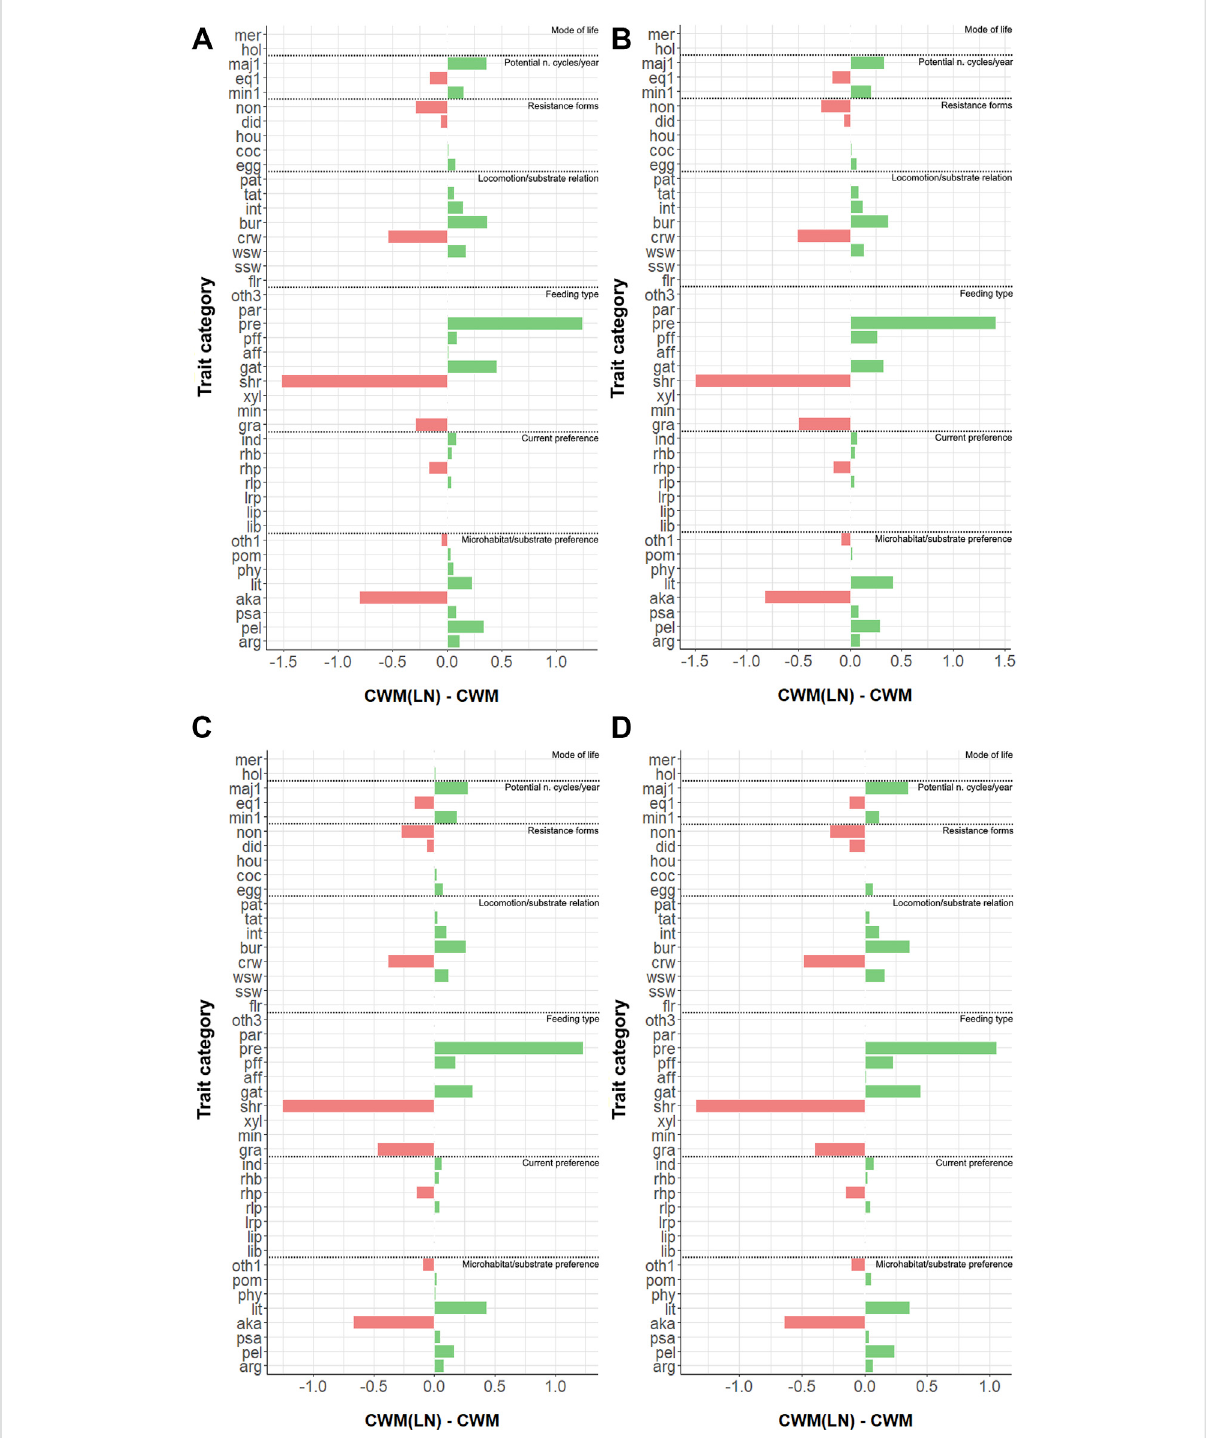
FIGURE 3 MeasureddifferencesbetweenCWM(LN)andCWM(=CWMDIFF)foralltraitcategoriesfor (A) site1; (B) site2A; (C) site2C;and (D) site2D.Refer to Supplementary Table S1 for the abbreviations of trait